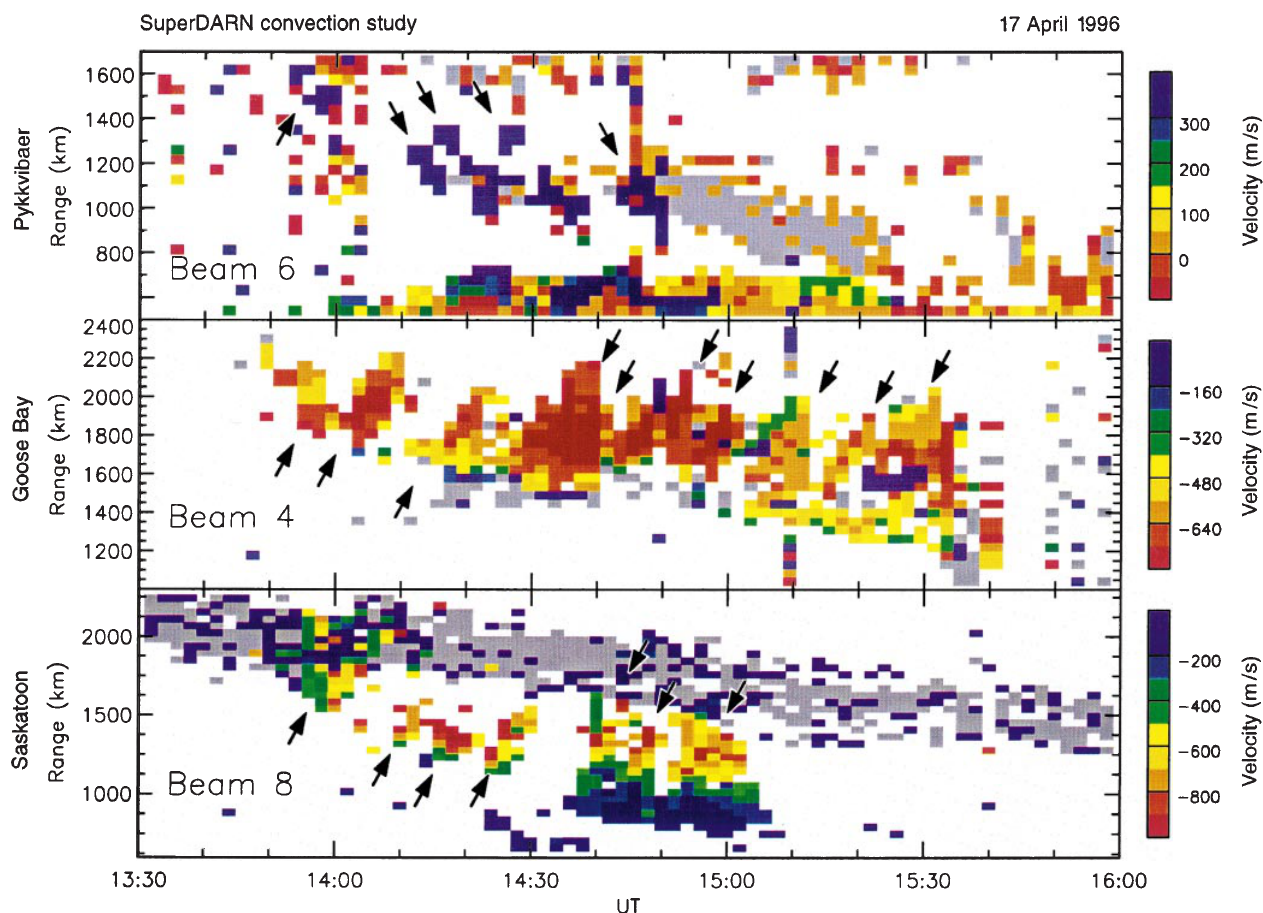
signatures; arrows in the Saskatoon and Pykkvibaer radar panels indicate the occurrence of return flow